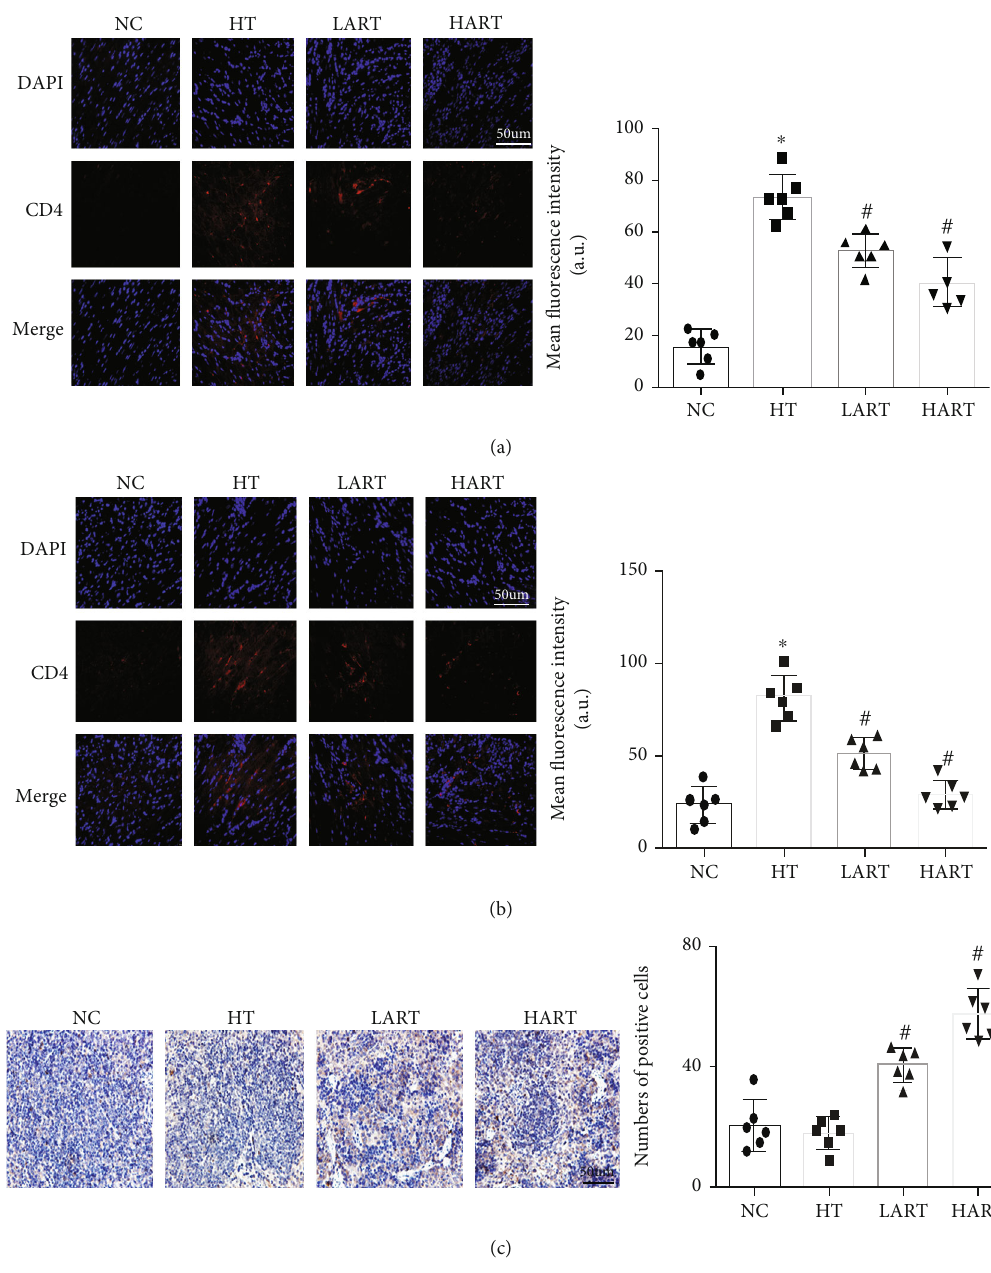
Figure 2: (a) Immuno fl uorescence staining and mean fl uorescence intensity of CD4 in grafts (blue: DAPI, red: CD4); (b) immuno fl uorescence staining and mean fl uorescence intensity of CD8 in grafts (blue: DAPI, red: CD8); (c) immunohistochemistry of FOXP3 and statistics graph of positive cells ’ number per unit ( ∗ P < 0 : 05 compared with NC; # P < 0 : 05 compared with